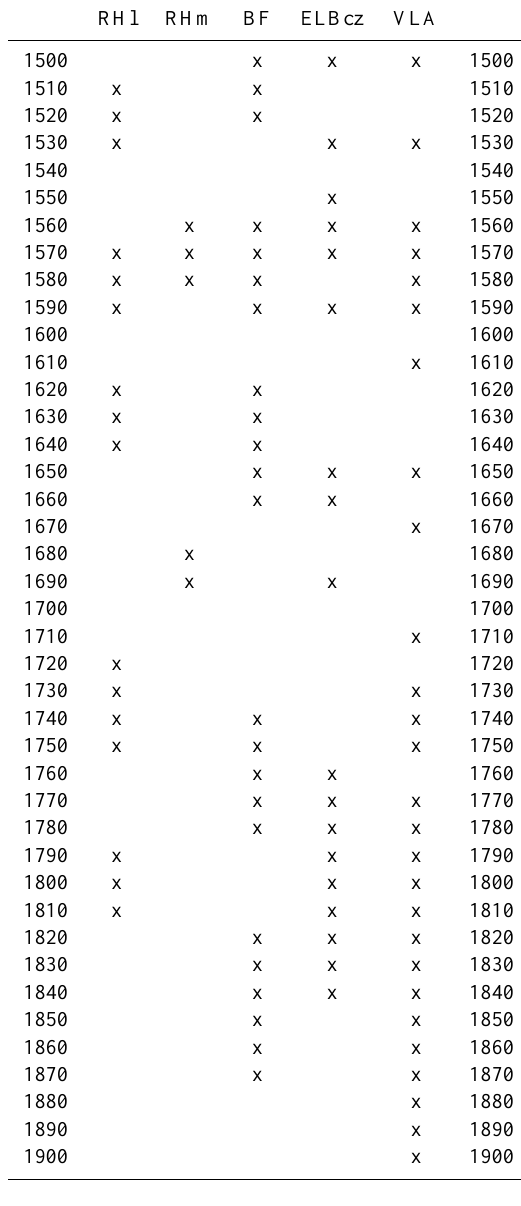
Table 4. Comparison of selected flood frequencies. Lower Rhine (RHl), Middle Rhine (RHm), Czech Elbe (ELBcz), Vl- tava (VLA) and Bavarian Foreland (BF). Due to the decadal vi- sualization, beginnings and endings of the marked periods under- lie a certain blur. Data altered according to Glaser (2008) and Brázdil